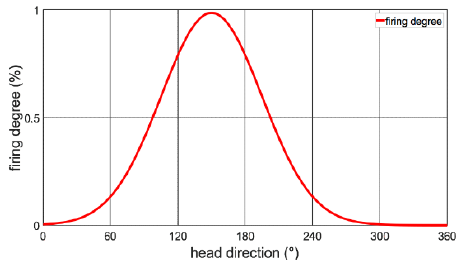
Figure 2. Response curve of firing of a head-direction (HD) cell.